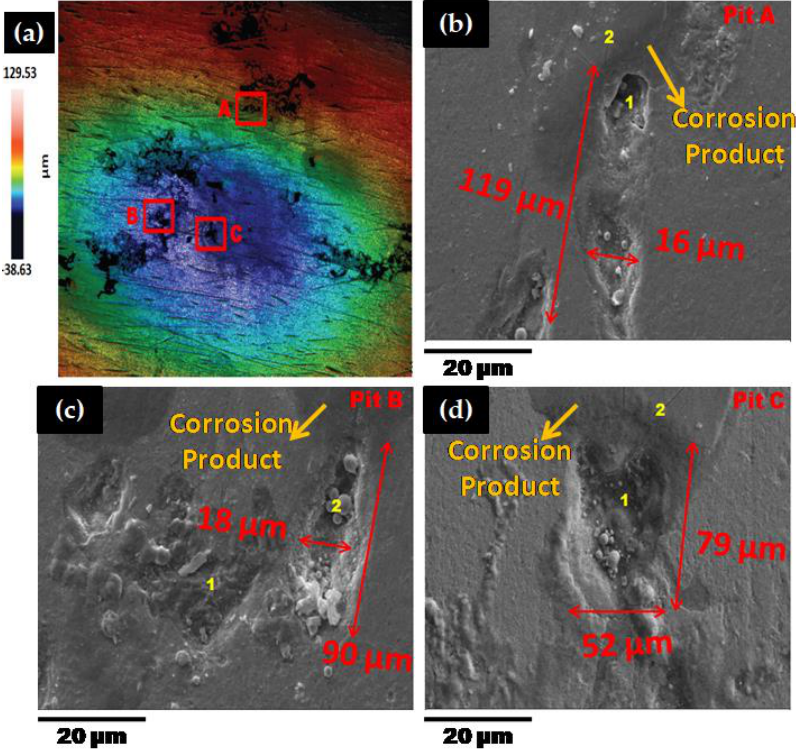
Figure 11. Micrographs of 90° elbow exit section for 10 wt.% sand fines concentration: ( a ) confocal and ( b – d ) SEM inside pit (1) and outside pit (2). ( b – d ) SEM inside pit (1) and outside pit